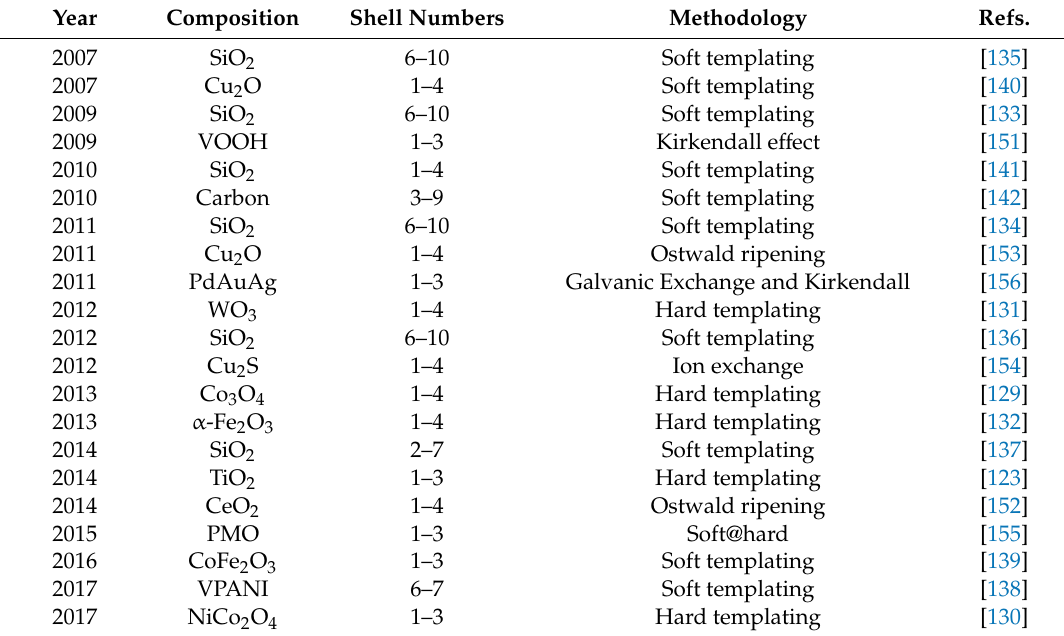
Table 1. Summary of typical multiple-shelled hollow spheres